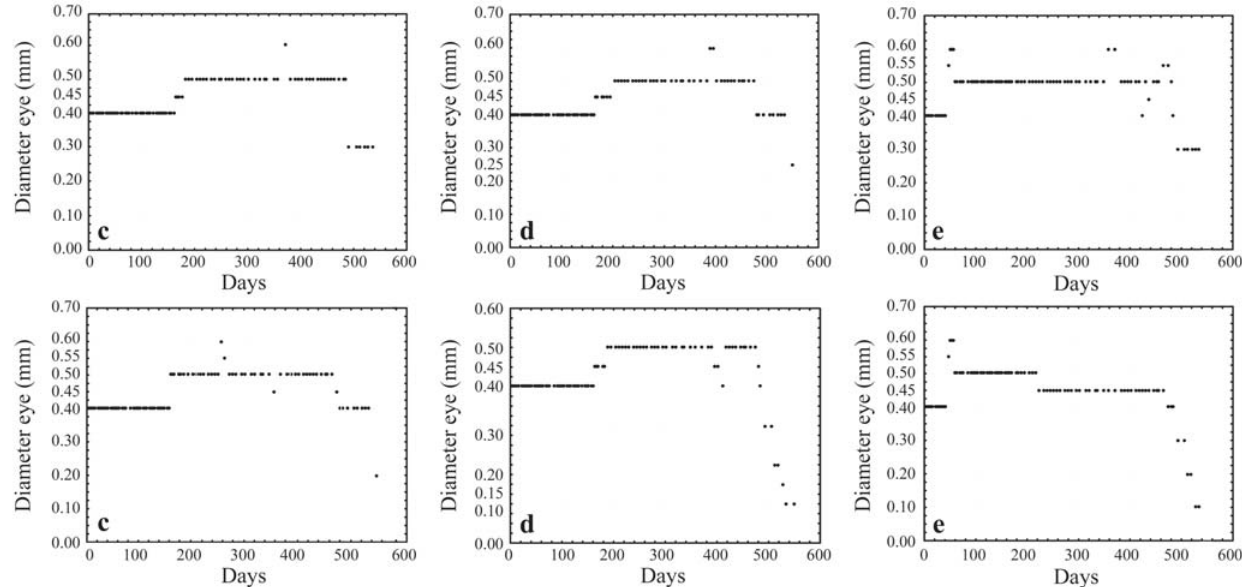
Fig. 6. Eye size (diameter, in mm) versus age (in days) in three selected specimens (from left to right) of Ancistrus cryptophthalmus from Passa Três Cave; right eye on the top, left eye on the